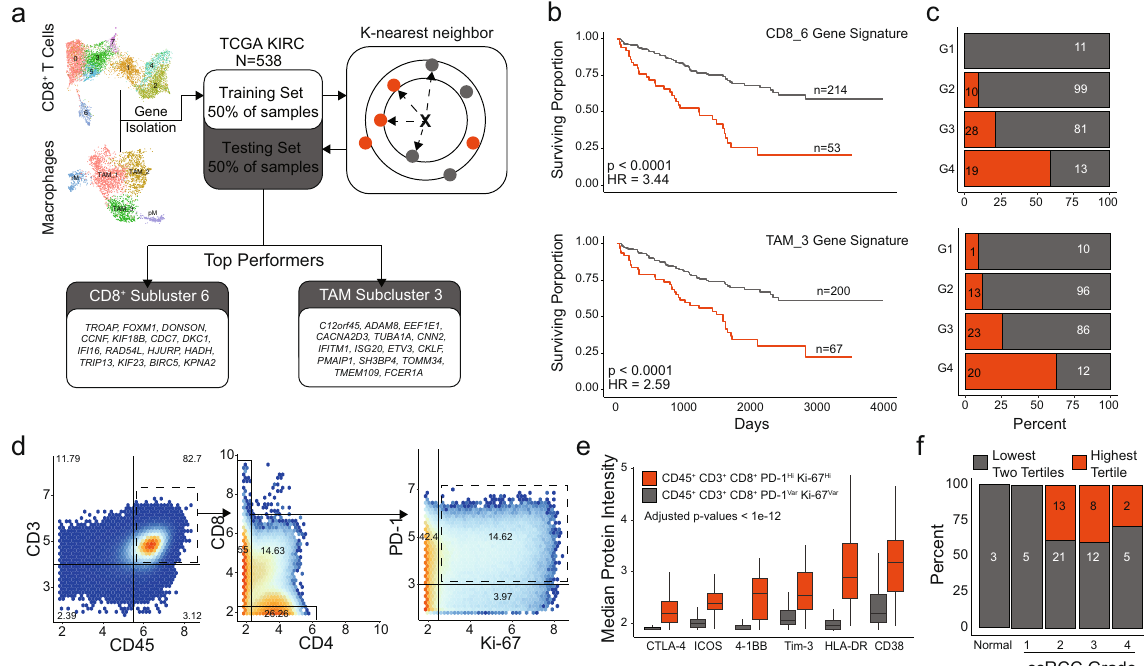
Fig. 6 Prognostic values of gene signatures derived from CD8 + T cell and TAM subclusters. a Schematic diagram of the machine-learning approach for signature development, selection and testing based on the k-nearest neighbors algorithm using the TCGA renal clear cell carcinoma data set. b Kaplan – Meier curves for overall survival in testing subset for the CD8_6 subcluster signature with corresponding distribution of histological grades by model assignment. c Kaplan – Meier curves for overall survival in testing subset for the TAM_3 subcluster signature with corresponding distribution of histological grades by model assignment with logrank p values. d Density plots for 937,713 T cells isolated from four healthy samples, 68 primary ccRCC, four metastasis, and quanti fi ed using mass cytometry 18 . e Markers with increased median expression in CD45 + CD3 + CD8 + PD-1 + Ki-67 + cells compared to other CD8 + cells. Adjusted p values < 1e − 12 for all indicated markers using Welch ’ s T test. f ccRCC primary tumor and healthy samples subdivided into tertiles by the proportion of CD45 + CD3 + CD8 + PD-1 + Ki - 67 + relative to the entire CD45 + CD3 + CD8 + pool by histological grade. COMMUNICATIONS BIOLOGY| (2021) 4:122